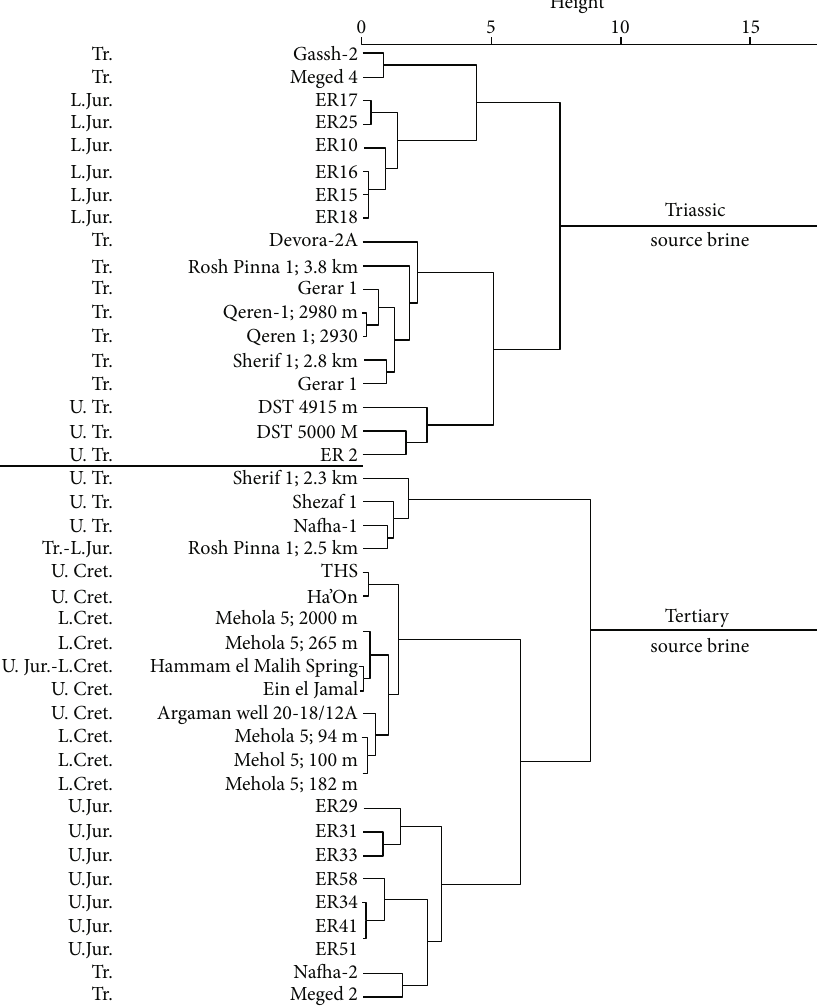
Figure 8: Dendrogram of brines presented in Table 1. The height or distance describes the dissimilarities of the indicated groups. The upper main group of Triassic brines dissimilates to the lower one representing the Tertiary